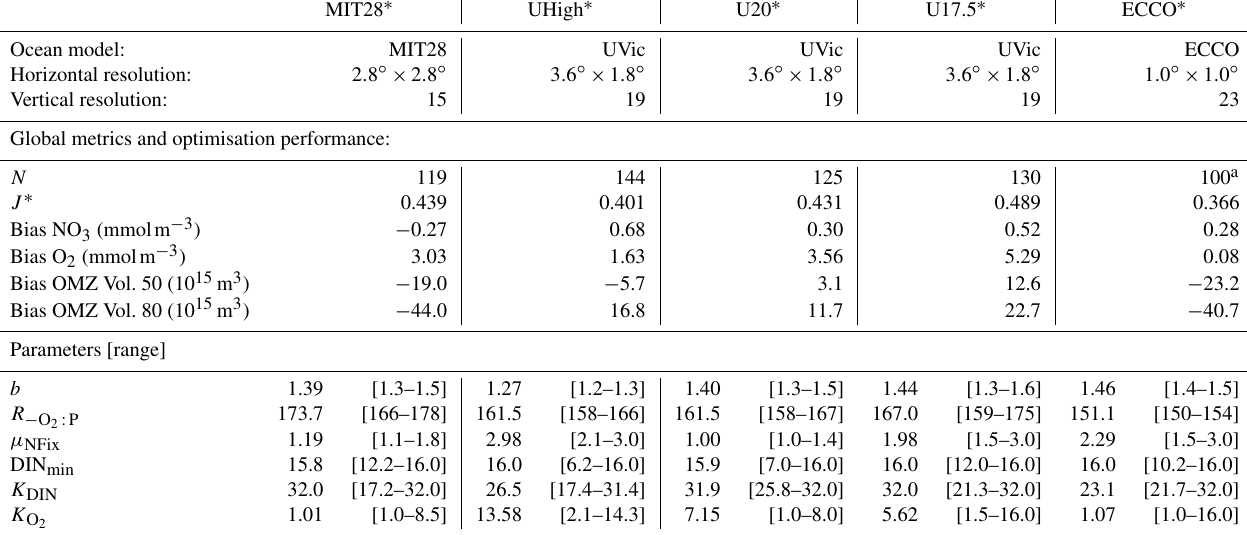
Table 1. General setup, performance and results of optimisations expressed as N , the number of generations (each with a population size of 10) until convergence of the optimisation algorithm, the minimum misfit J ∗ (the target of optimisation), bias of global average nitrate and oxygen, OMZ volume (for OMZs defined by O 2 < 50 and O 2 < 80mmolm − 3 ), optimal parameters, and their uncertainties. To determine parameter uncertainty, we defined the group (cid:127) of model simulations whose misfit J k deviates less than 1% from the optimal misfit J ∗ ( J k /J ∗ − 1 ≤ 0 . 01). For each parameter the first value gives the optimal parameter, averaged over the last generation, and the range of all individuals of (cid:127) is given in square brackets. See Sect. 2.1 for more information on the setup of the offline circulations. MIT28 ∗ UHigh ∗ U20 ∗ U17.5 ∗ ECCO